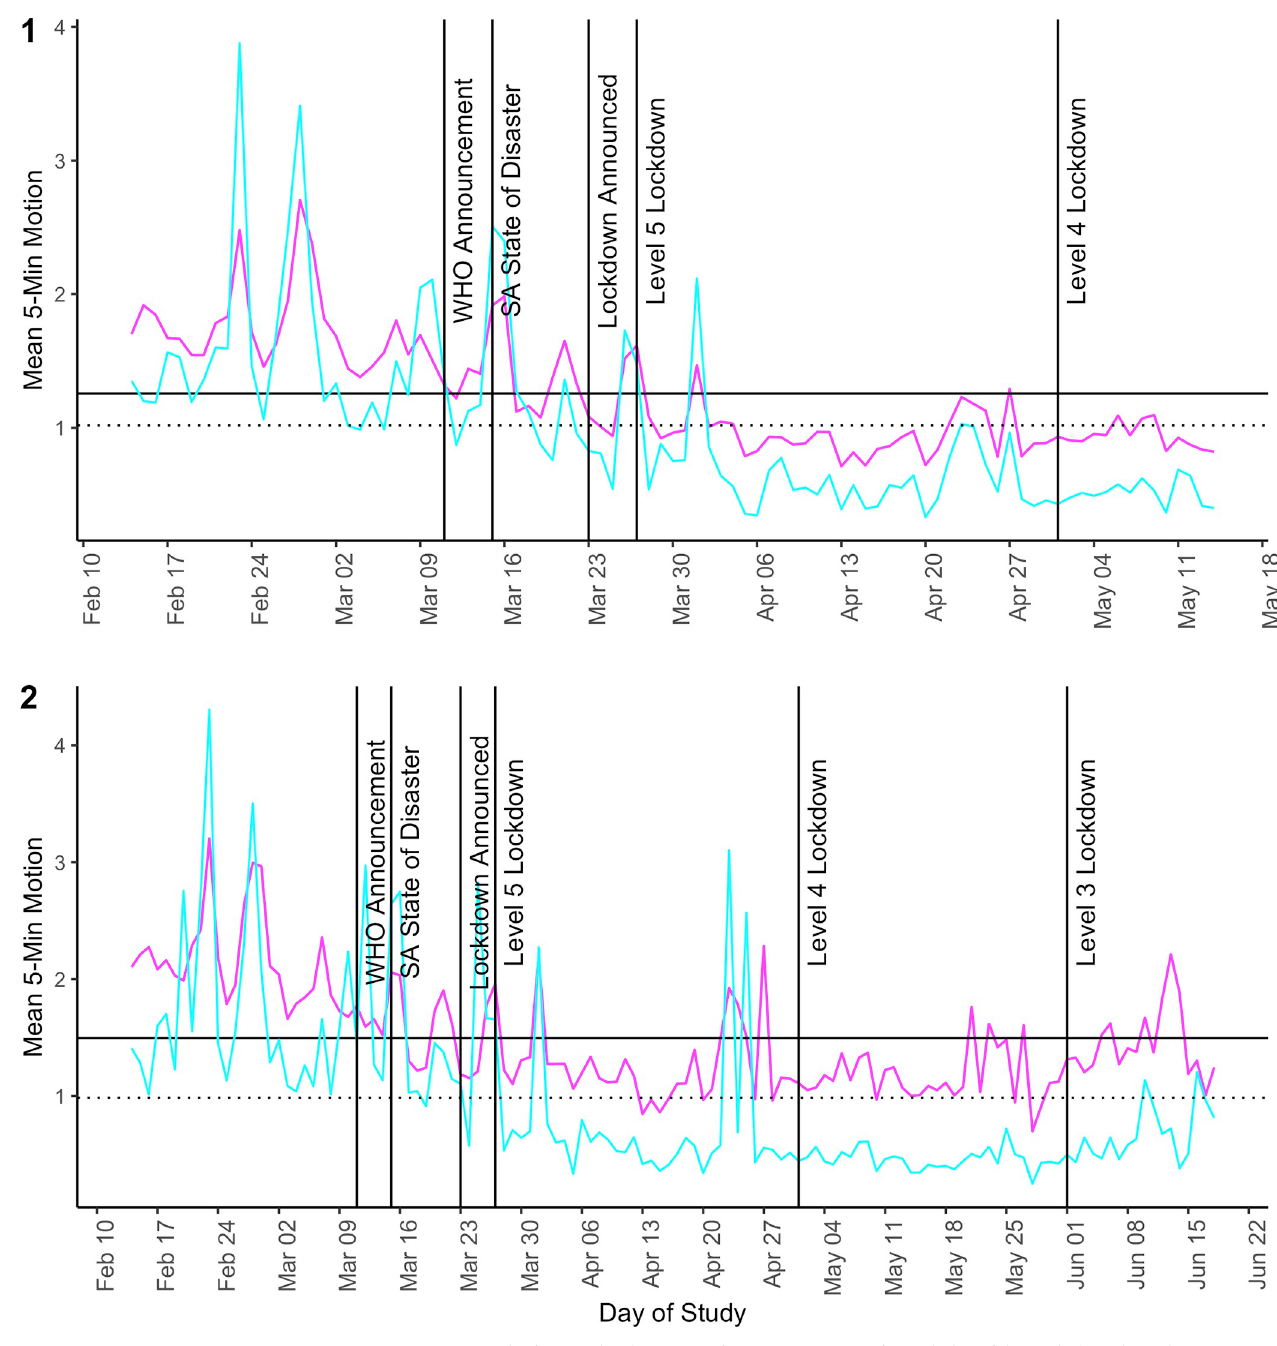
Fig 1. Average five-minute motion over the study period. The figures plot the average five-minute motion for each day of the study (Panel 1: Feb 14 –May 14; Panel 2: Feb 14 –June 18). The x-axis shows the date on every Monday. The pink line represents data from sensors installed in paths (Panel 1: 60; Panel 2: 21), while the blue line represents data from sensors installed in compounds (Panel 1: 26; Panel 2: 18). The black horizontal line is overall five-minute path average and the dotted black line is the overall five-minute compound